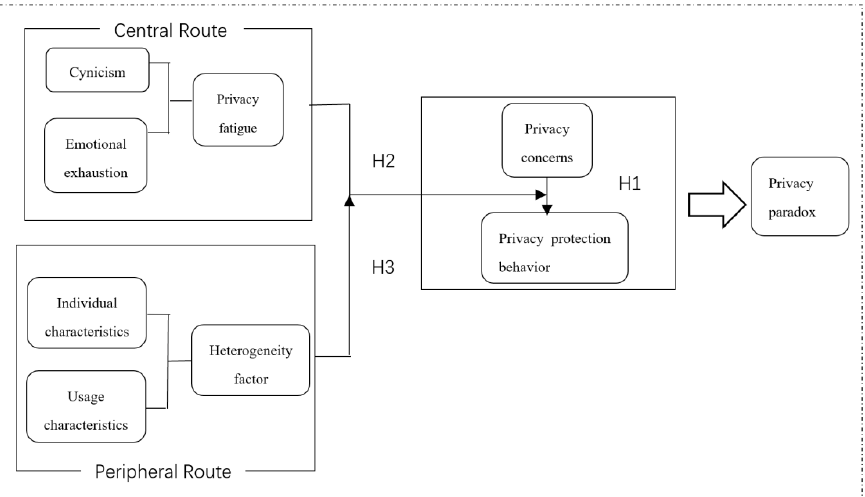
Figure 1. The research model.